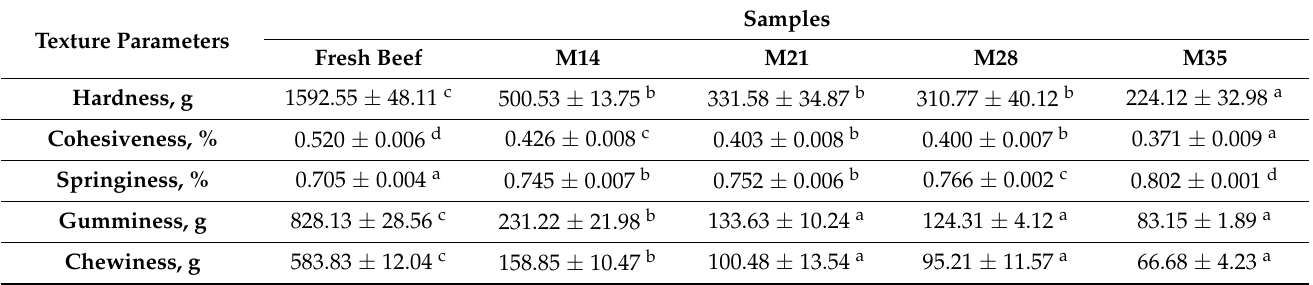
Table 3. Dynamics of change in texture parameters of beef during dry-aging process (results are presented as averages ± standard